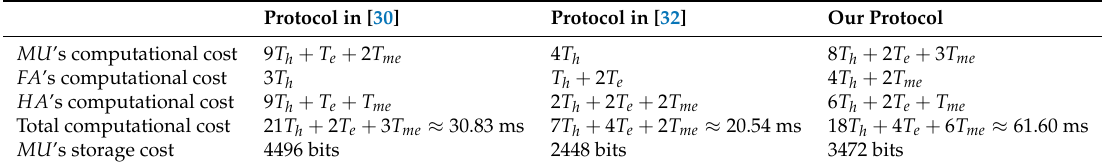
Table 3. Performance comparison.